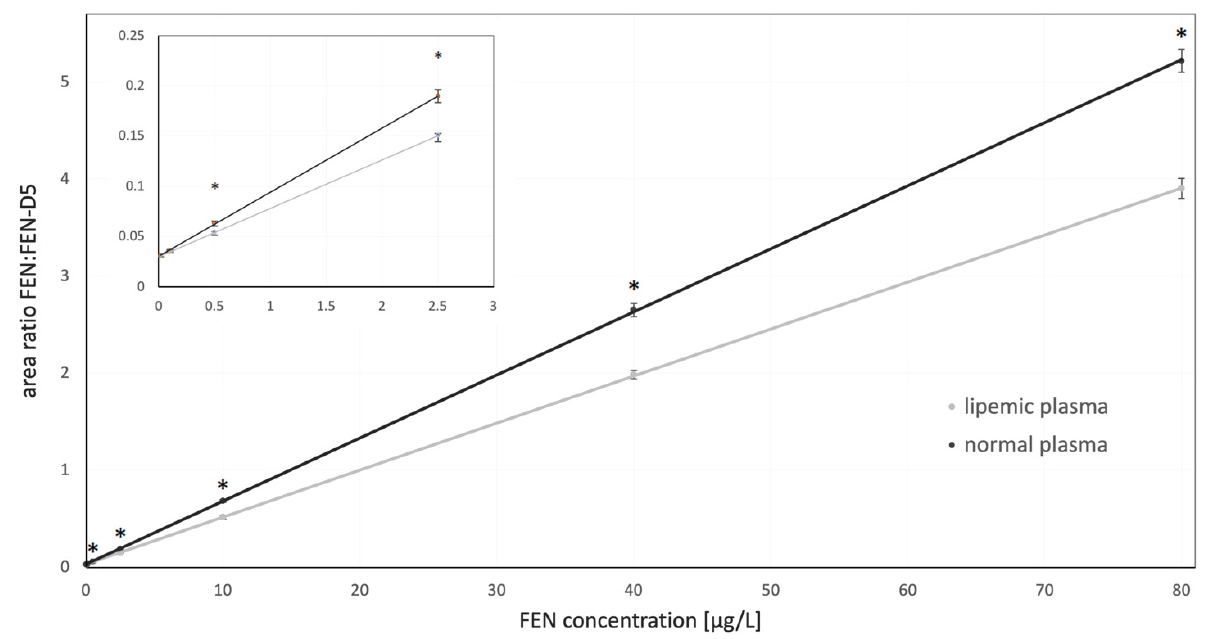
Figure 2. The difference between calibration curves in normal and lipemic plasma samples. The smaller panel represents the lower part of the calibration curves. Vertical bars represent standard deviations associated with the results. The significant differences between the area ratio observed in the two matrices are indicated by asterisks ( p < 0.01).